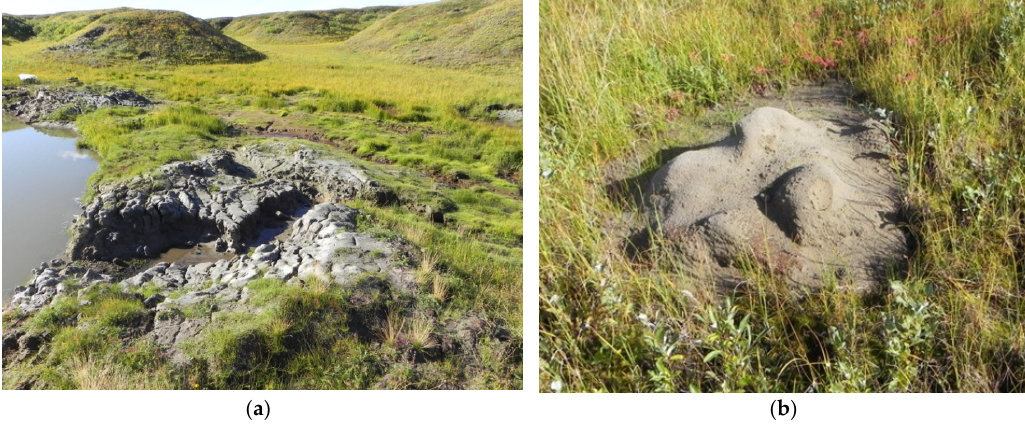
Figure 12. Accumulative piles in the vicinity of AntGEC: ( a ) fragments of a partially washed away large accumulative form immediately adjacent to the crater rim; ( b ) a washed out residue of an ejected sand block with a diameter of 1 m to 1.2 m in a gully bottom (both photographs by A. V. Khomutov, August 2016).